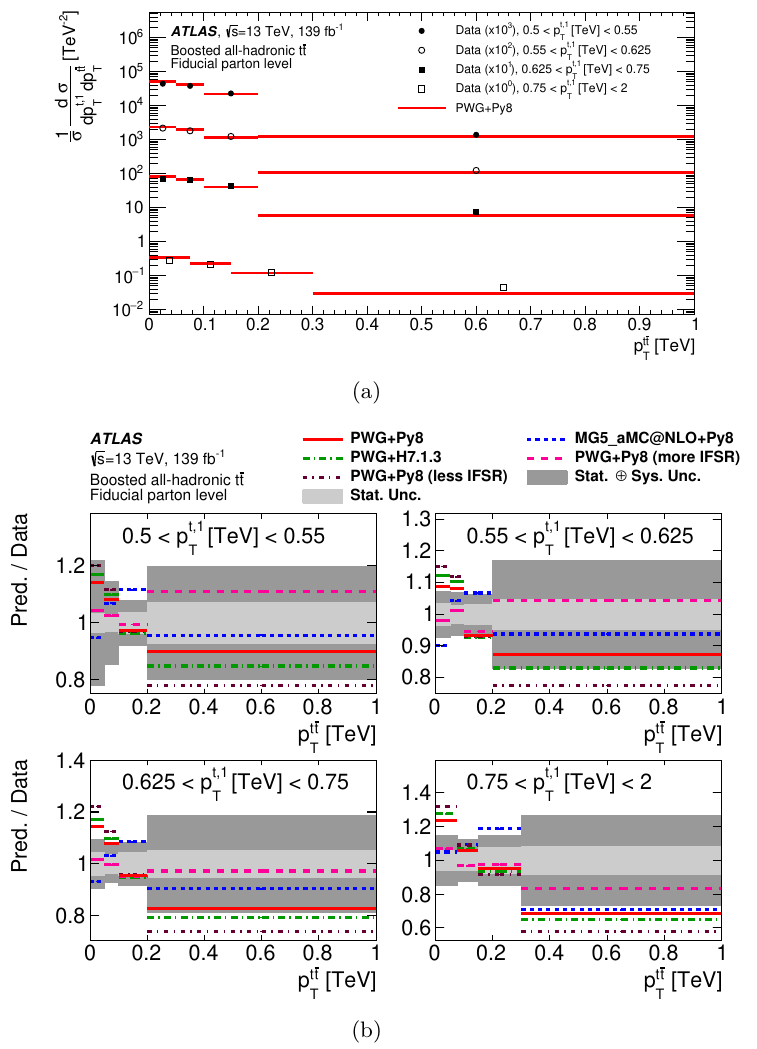
Figure 27 . (a) Normalized parton-level fiducial phase-space double-differential cross-sections as a function of the p T of the leading top quark and the p T of the t ¯ t system, p t ¯ t the Powheg+Pythia 8 calculation. Data points are placed at the centre of each bin and the Powheg+Pythia 8 calculation is indicated by solid lines. The measurement and the prediction are normalized by the factors shown in parentheses to aid visibility. (b) The ratios of various MC calculations to the normalized parton-level fiducial phase-space differential cross-sections. The dark and light grey bands indicate the total uncertainty and the statistical uncertainty, respectively, of the data in each